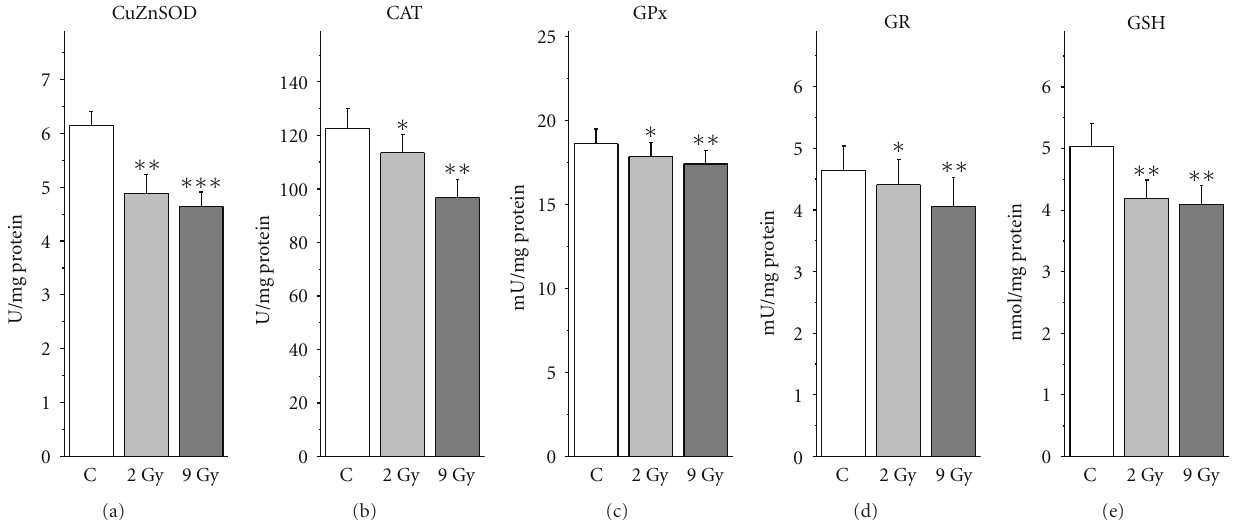
Figure 3: AO enzyme activities and concentration of GSH in blood cells nonirradiated (C) and irradiated with 2Gy and 9 Gy of γ -radiation, in healthy women above 58 years. The data are given in mean values ± SEM; ∗ P < 0 . 05, ∗∗ P < 0 . 01, ∗∗∗ P < 0 . 001 in comparison to C (student’s paired t -test).